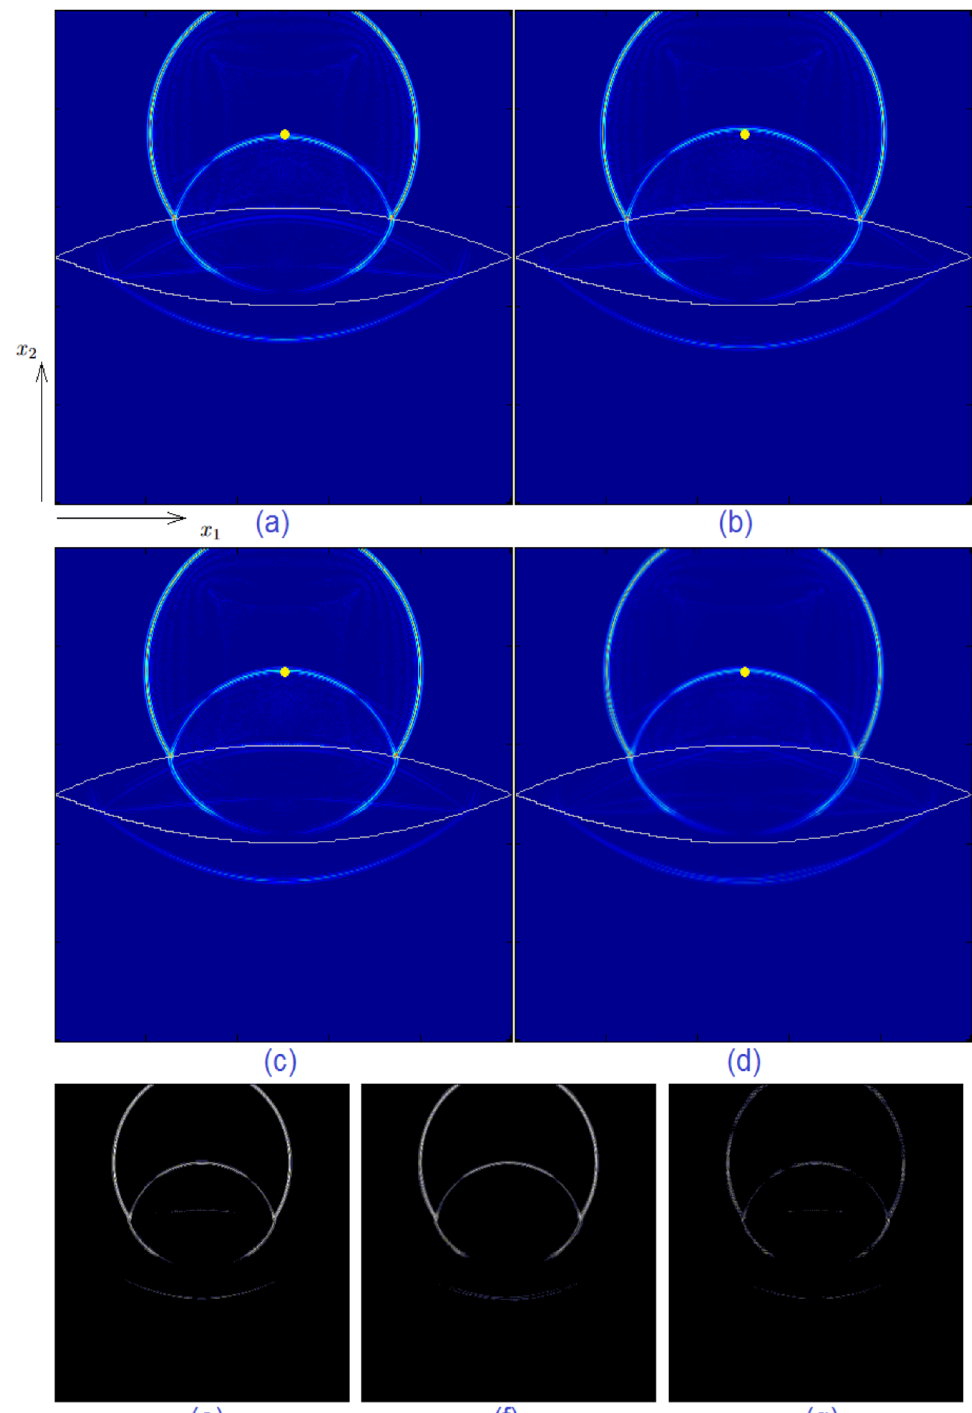
Fig. 7. Snapshot time from t =190 m s (a), t =200 m s (b), and t = 195 m s (c), for the radiation pattern of a point force (directed along x 2 ) generating a Ricker pulse with central frequency 250 kHz and spectral bandwidth 10kHz, located at 12.5 cm from the top and 25cm from the left and the right edge of a fi eld of 50 cm by 50 cm, applied to the “ Lens 2 ” ; morphing result (d) between (a) and (b), (e) is (c) transformed in a grayscale image, (f) is (d) transformed in a grayscale image and (g) is the absolute value of the difference between (e) and